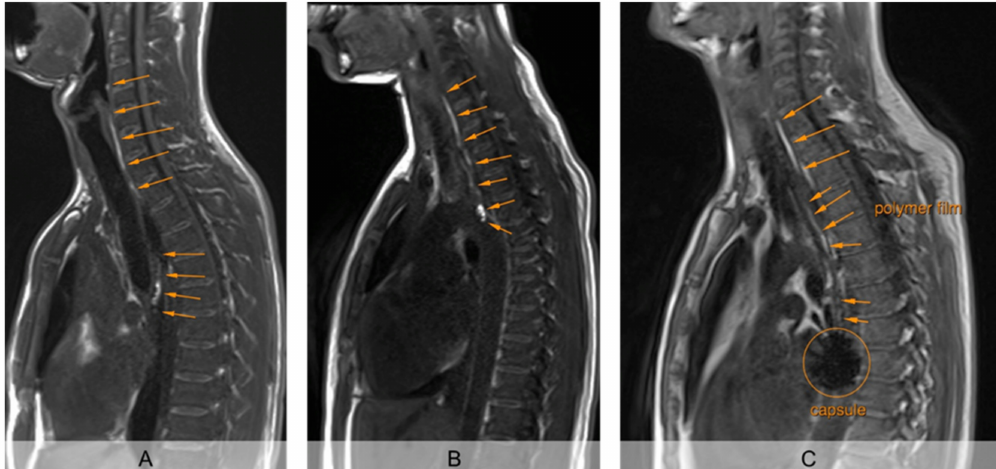
Figure 2. Exemplary representation of sagittal imaging 5 min after application of the EsoCap system. ( A ): (Almost) completely unrolled film (study setup A, without additional sinker). ( B ): Incompletely unrolled film, with particularly intense signal of the unrolled film in the capsule (study setup A, without additional sinker). ( C ): (Nearly) completely unrolled film, using sinker, loaded with iron oxide for signal extinction (study setup B).